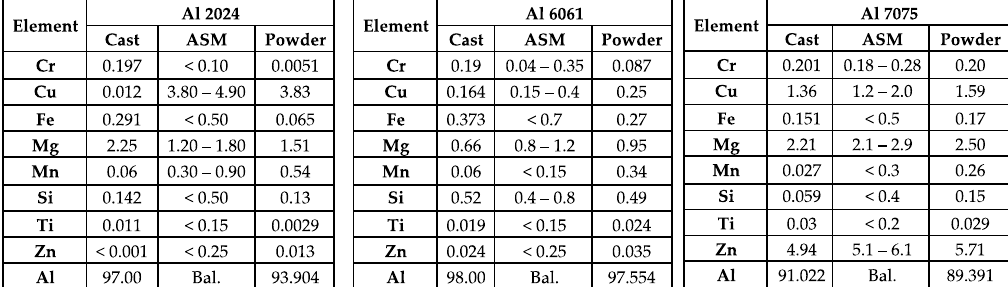
Figure 4. Experimentally derived chemistries of the gas-atomized powders as well as the as-cast samples compared to the standard compositional ranges defined by ASM International for each of the three systems studied herein: Al 2024, Al 6061, and Al 7075.